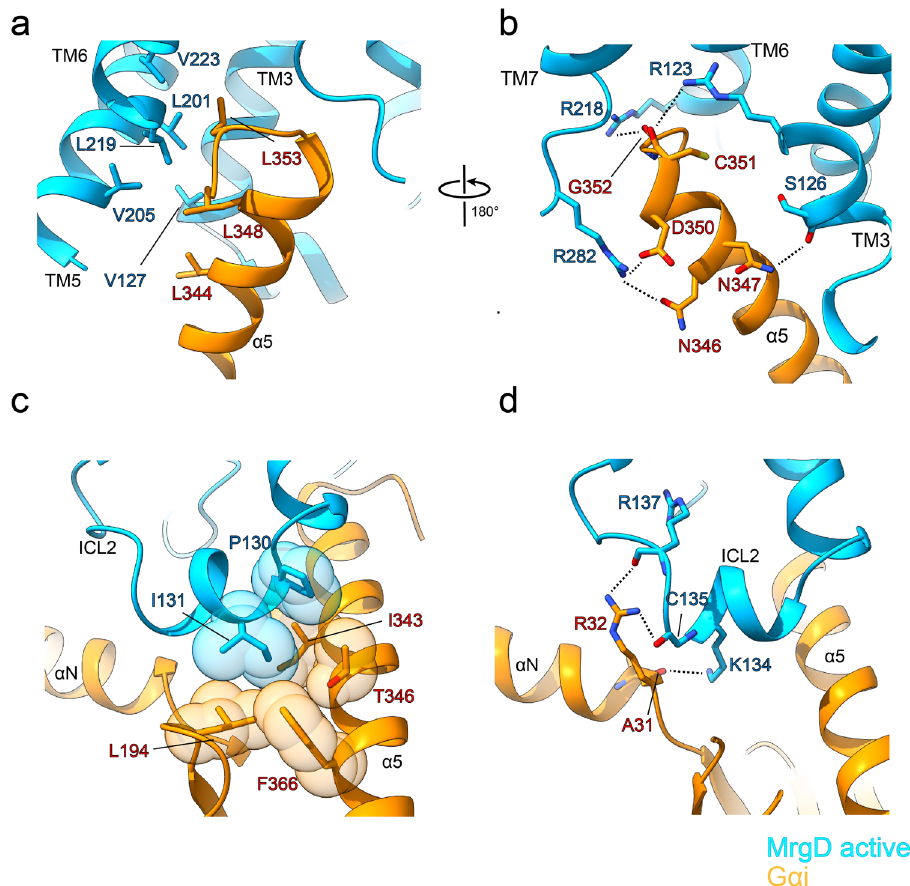
Fig. 5 Binding interface between MrgD and G protein. a , b Hydrophobic ( a ) and hydrophilic ( b ) interactions between MrgD and Gi around the α 5 helix of Gi. c , d Hydrophobic ( c ) and hydrophilic ( d ) interactions between ICL2 of MrgD and the α N- α 5 cleft of Gi. The residues involved in the interaction are shown as stick models. Black dashed lines indicate hydrogen